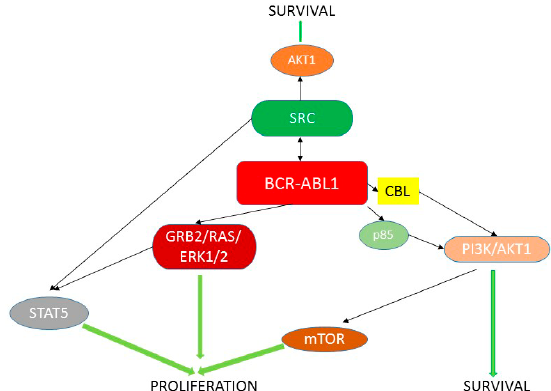
Figure 2. Some BCR-ABL1 signaling pathways important for cancer transformation (adapted from [2]).